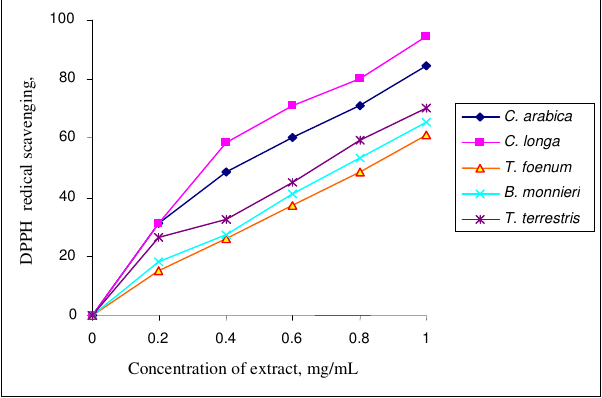
Figure 1. DPPH radical scavenging assay data represents, mean ±SEM, for